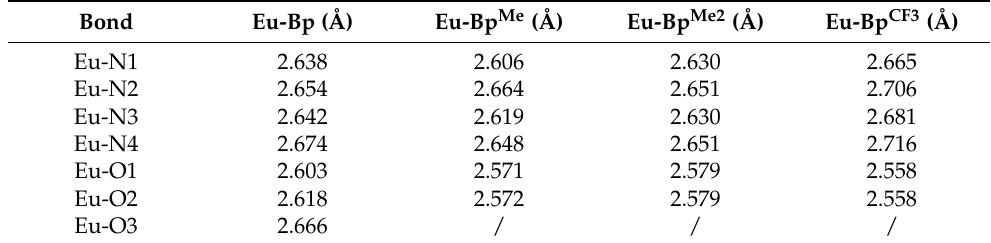
Figure 2. The crystal structures of the investigated Eu(II) complexes: ( a ) Eu-Bp; ( b ) Eu-Bp Me ; ( c ) Eu-Bp Me2 ; ( d ) Eu-Bp CF3 ; and ( e ) coordination geometry of the four Eu(II) complexes, Eu-Bp, Eu-Bp Me , Eu-Bp Me2 and Eu-Bp CF3 are arranged from top to bottom. For clarity, the hydrogen atoms are omitted. Eu atoms are represented in cyan, O in red, B in pink, N in blue, C in gray, and F in green. Table 1. The Eu-N and Eu-O bond lengths of the four Eu(II) complexes. The labels for coordinated nitrogen atoms and oxygen atoms are shown in Figure